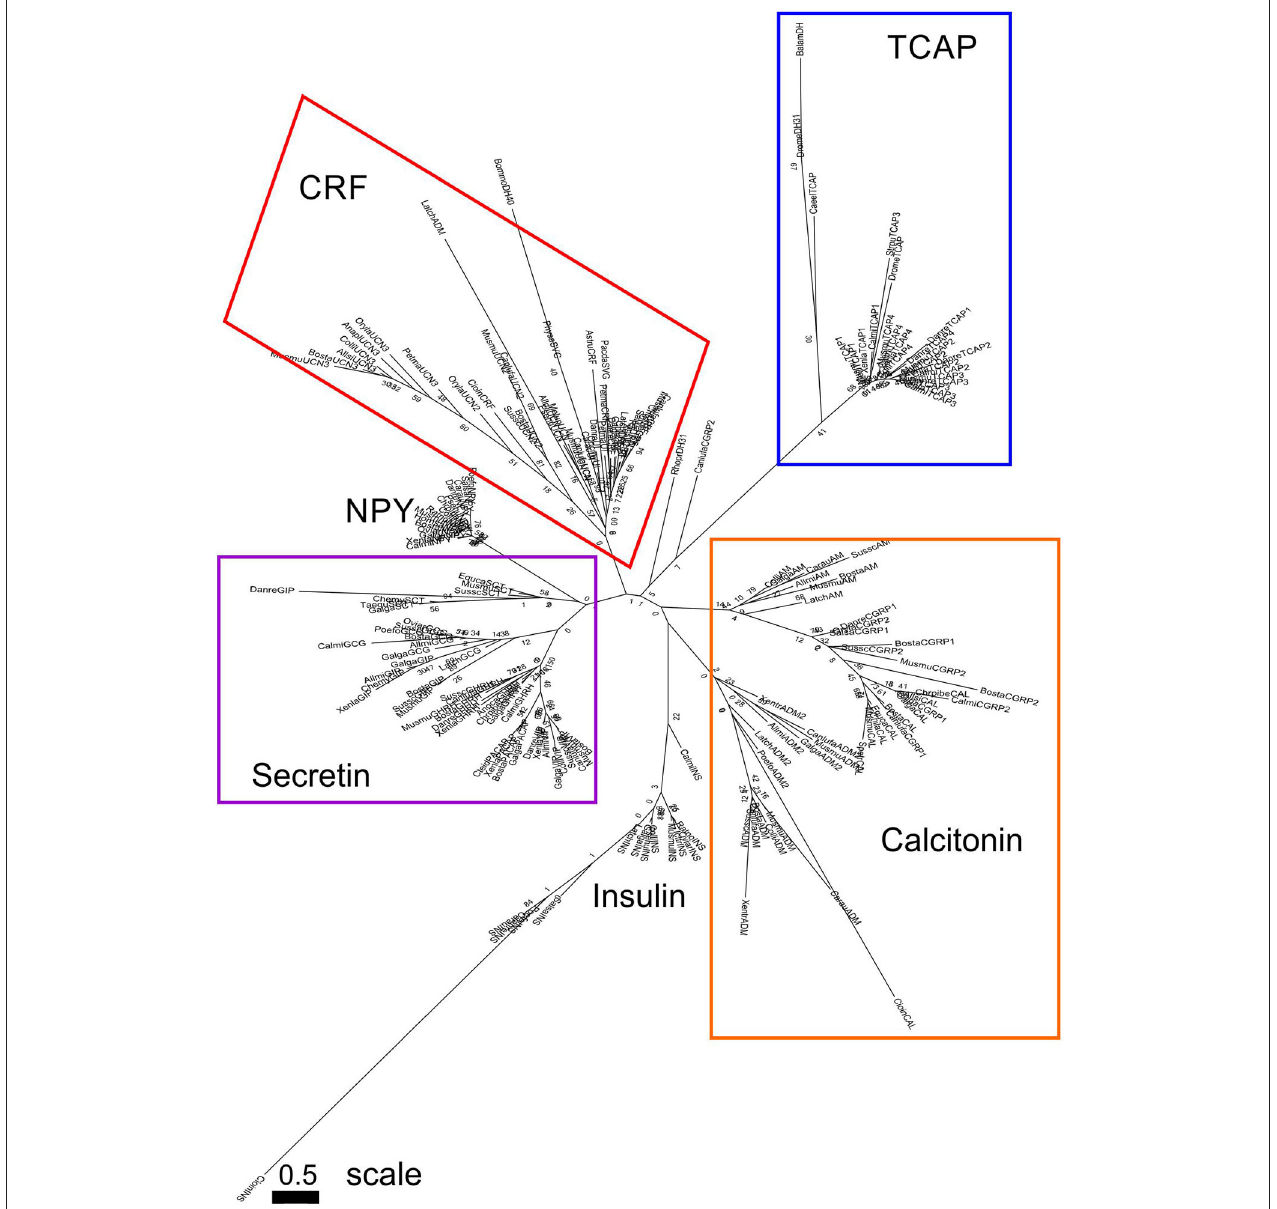
FIGURE 3 | Phylogenetic analysis of CRF, calcitonin, insulin, and secretin family pre-propeptides with TCAP propeptides (rooted to TCAP). Each family is highlighted with a different color: CRF (red), calcitonin (orange), secretin (purple), TCAP (blue). Analysis was conducted using the maximum likelihood method based on the JTT + G matrix-based model (lnL = − 11224.5064; + G, parameter = 1.3976) (41). Initial trees for the heuristic search were obtained by applying the NJ method to a matrix of pairwise distances estimated using a JTT model. Branch lengths represent the number of substitutions per site, with the tree shown to scale. Bootstrap analysis involved 1,000 replicates. CRF family: CRF, corticotropin-releasing factor; TCN, teleocortin; UCN, urocortin; UCN2, urocortin 2; UCN3, urocortin 3; UI, urotensin; SVG, sauvagine; DH, diuretic hormone; Calcitonin family: CALC, calcitonin; CGRP1, calcitonin-gene-related peptide 1; CGRP2, calcitonin-gene-related peptide 2; AM, amylin; ADM, adrenomedullin; ADM2, adrenomedullin 2; Secretin family: SCT, secretin; GHRH, growth hormone releasing hormone; GIP, gastric inhibitory peptide; GCG, glucagon; PACAP, pituitary adenylate cyclase-activating peptide; VIP, vasoactive intestinal peptide; Reference groups: NPY, neuropeptide Y; INS, insulin; Outgroup: TCAP, teneurin C-terminal associated peptide. The scale bar indicates the level of magnification for the tree.